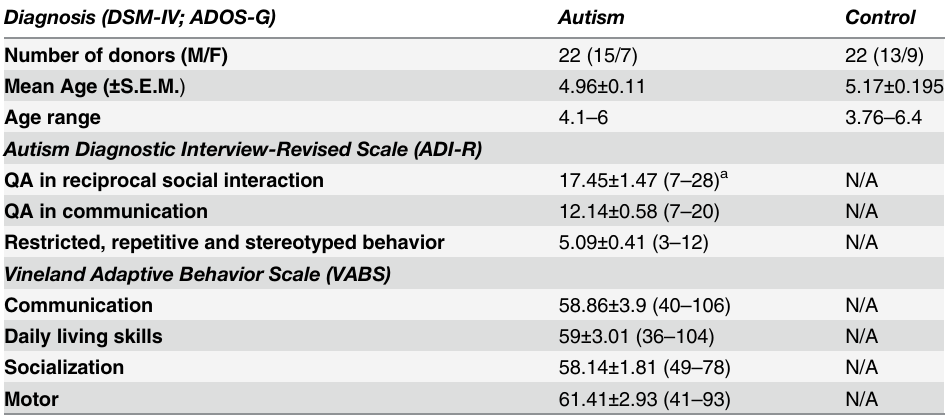
Table 1. Characterization of serum donors initially screened